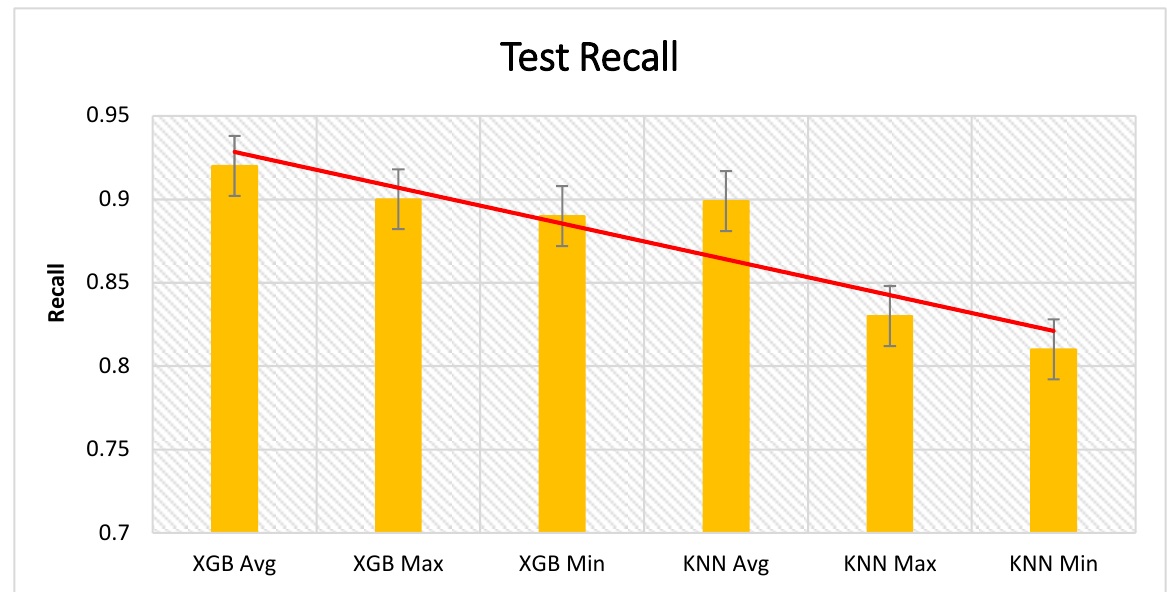
Figure 13. Cross validation of the test precision results.